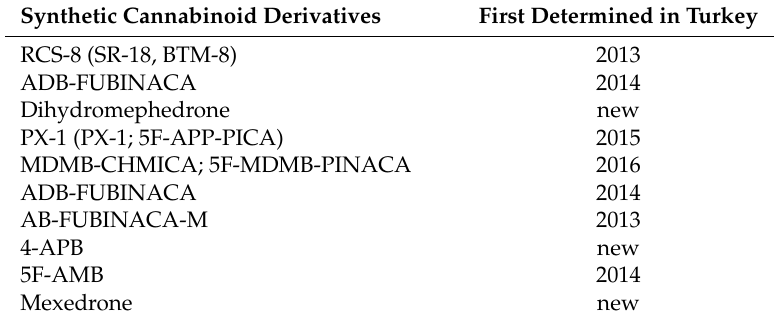
Table 3. Synthetic cannabinoids (SC) derivatives and metabolites determined using Orbitrap Technology with HR LC-MS/MS.